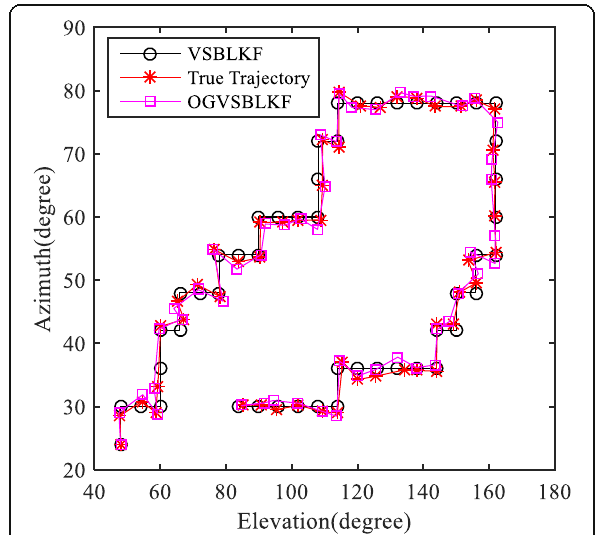
Fig. 12 Estimated azimuth as a function of time